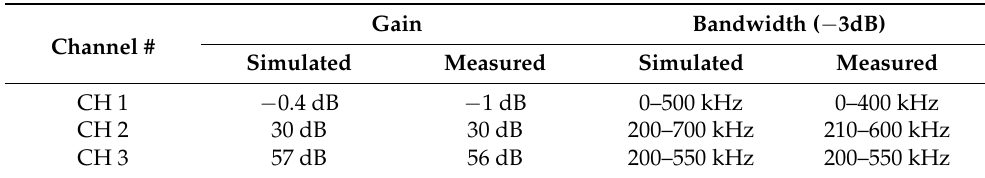
Table 3. Characterization of gain and frequency response of the three channels.